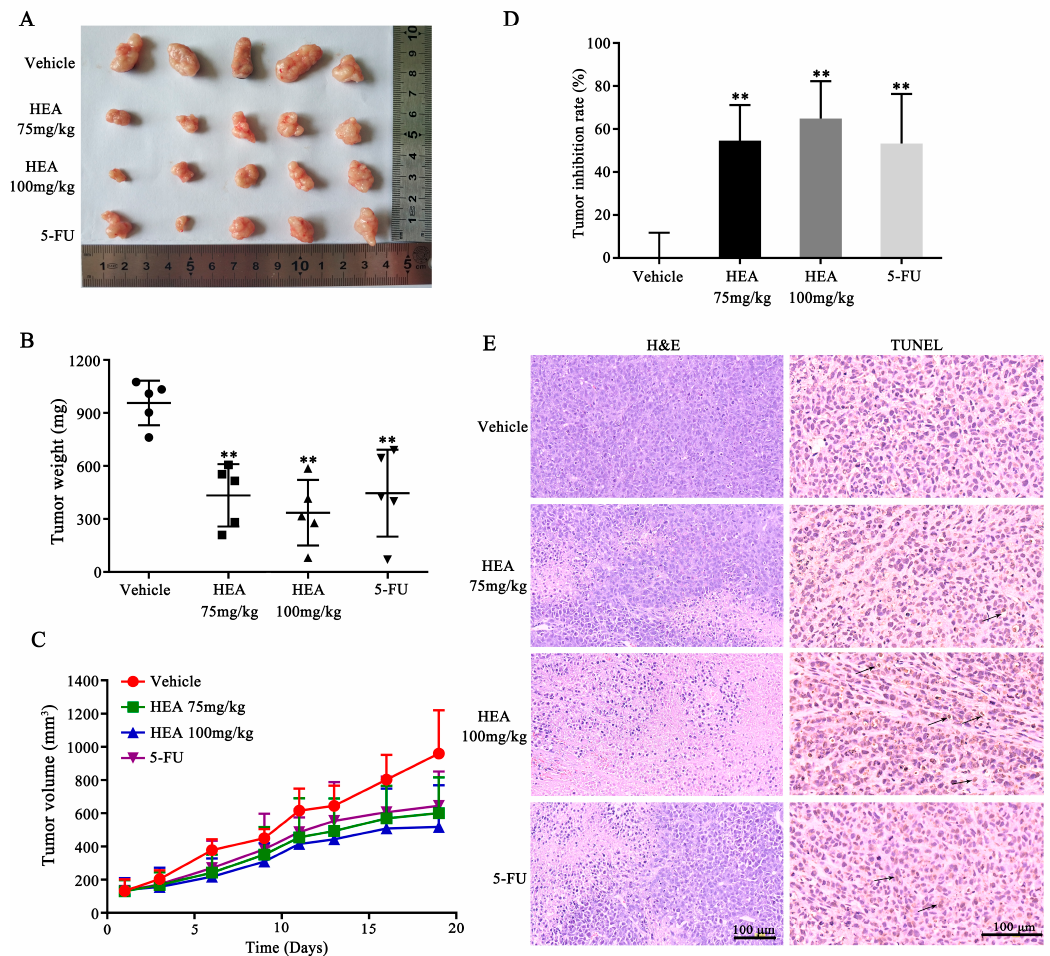
Figure 6. HEA inhibited tumor growth in the gastric carcinoma nude mouse model. ( A ) Morphology of the tumor xenograft resected from each nude mouse after 19 days of intragastric HEA administration. ( B ) Tumor weight of executed gastric carcinoma nude mouse model in each group. Data shown as mean ± SD. ( C ) Tumor growth curves. Data shown as mean ± SD (red circle: Vheicle, green square: HEA 75 mg / kg, blue triangle: HEA 100 mg / kg, purple triangle: 5-FU). ( D ) Tumor growth inhibition ratio (%) = (1 − tumor weight of treatment group / control group) × 100%. ( E ) H&E and TUNEL staining of xenograft tumor tissue. Black arrows indicate TUNEL-positive cells, that is, apoptotic cells. Scale bar = 100 µ m. ** p < 0.01 compared with 0 µ M HEA group, five repeats per group. We performed H&E and TUNEL staining on the sections of tumors. H&E staining